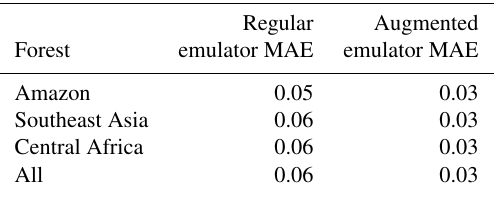
Table 1. Mean absolute error (MAE) rounded to the first signifi- cant figure for the regular emulator, using just the seven land sur- face inputs, and the augmented emulator, including temperature and precipitation.